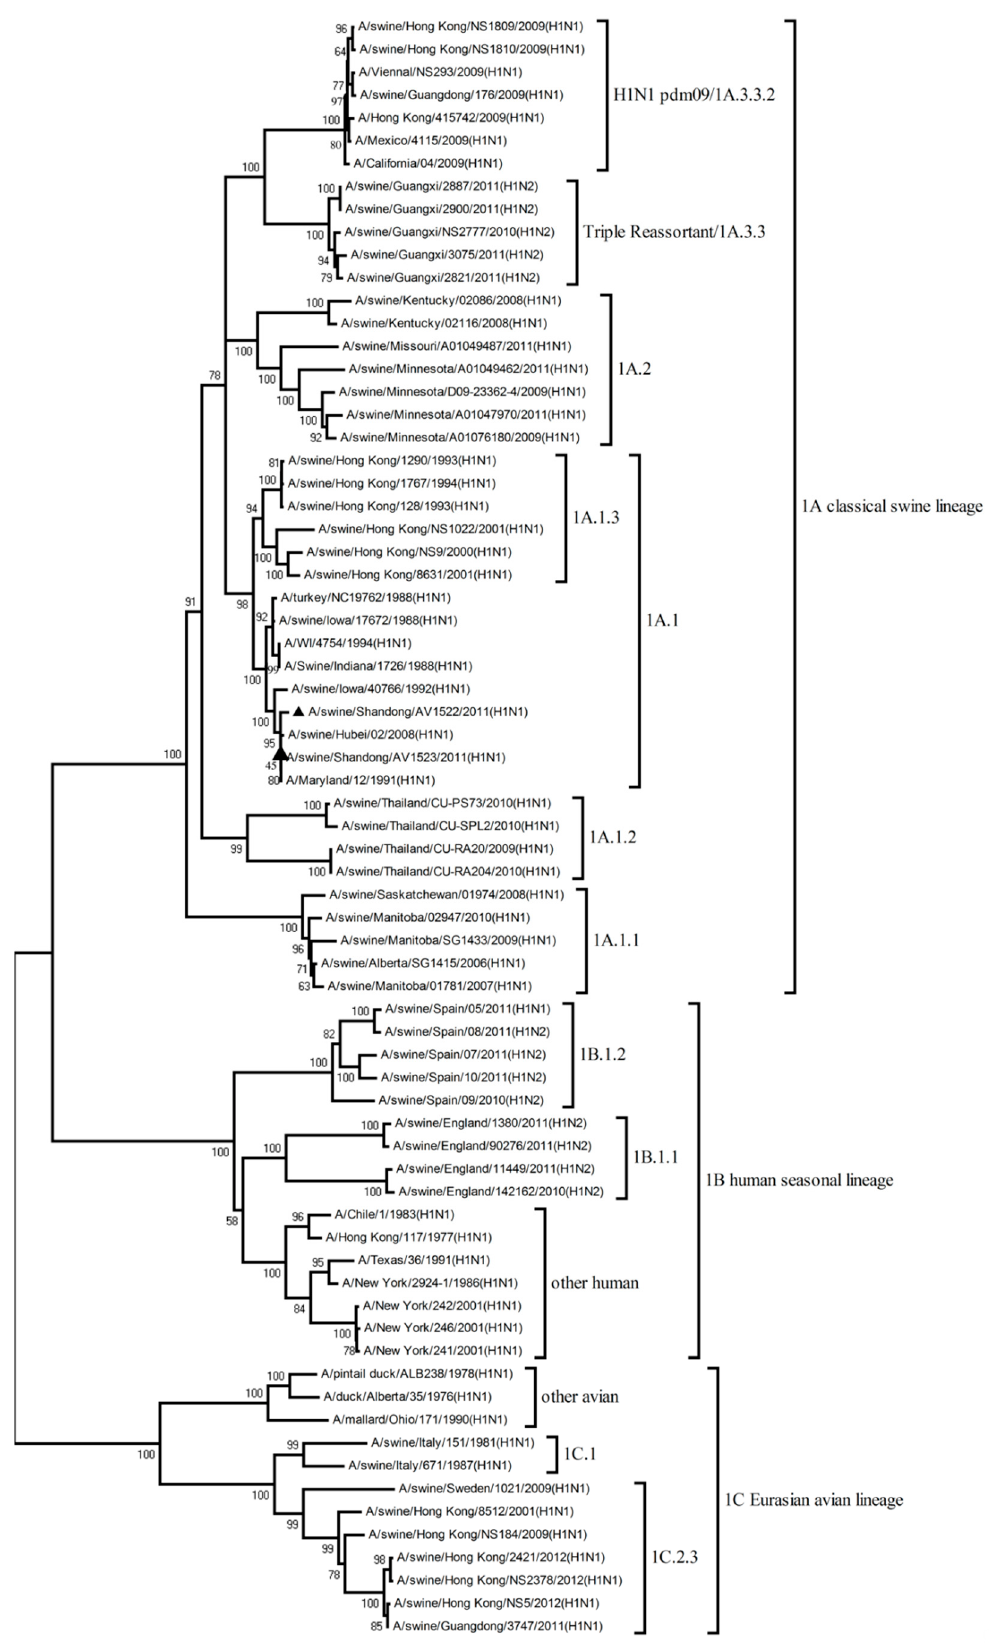
Figure 1. Phylogenetic analysis of the HA genes. The trees were constructed using the neighbor-joining method with the Maximum Composite Likelihood model and MEGA version 4.0 with 1000 bootstrap replicates. Our viruses were indicated by triangle marker “ ▲ ”.